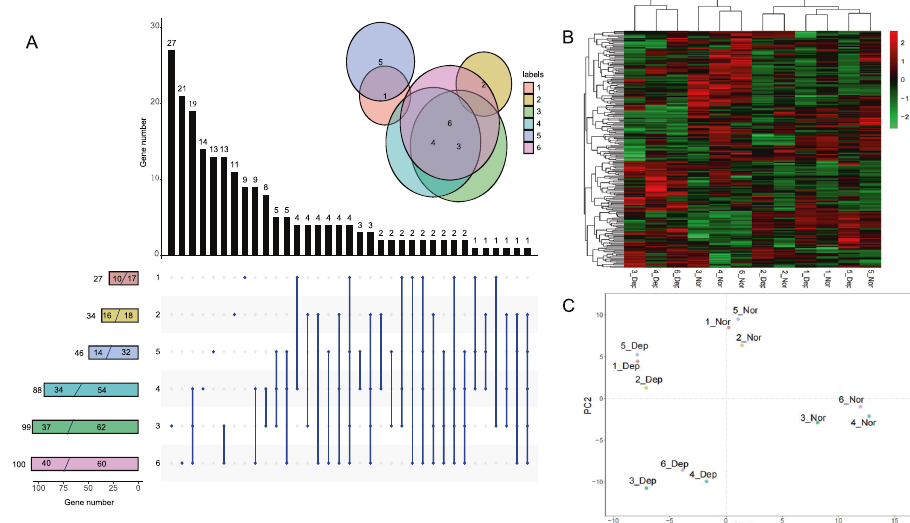
Fig. 1 The overall pattern of gene expression in peripheral blood lymphocytes of the six sib-pairs. A Upset plot of differentially expressed genes of 6 sib-pairs (fold-change > 2 or < 0.5 and paired T -test < 0.05). The Gene number refers to the number of differentially expressed genes in each pair of sib-pairs. The fi rst number in the bar is the number of up-regulated genes, and the second number is the number of down regulated genes. The blue dots and lines show the speci fi c genes and common genes between sib-pairs, and the black bar chart shows their corresponding number. The Wayne diagram shows the intersection of the differentially expressed genes between them. B Heatmap of differentially expressed genes in 6 sib-pairs. It divides sibling pairs into two groups, 1st, 2nd, and 5th and 3rd, 4th and 6th. Among them, 1st, 2nd, and 5th sib-pairs are clustered according to sibling pairs, while 3rd, 4th and 6th sib-pairs are clustered according to normal and depression. C PCA plot of differentially expressed genes of 6